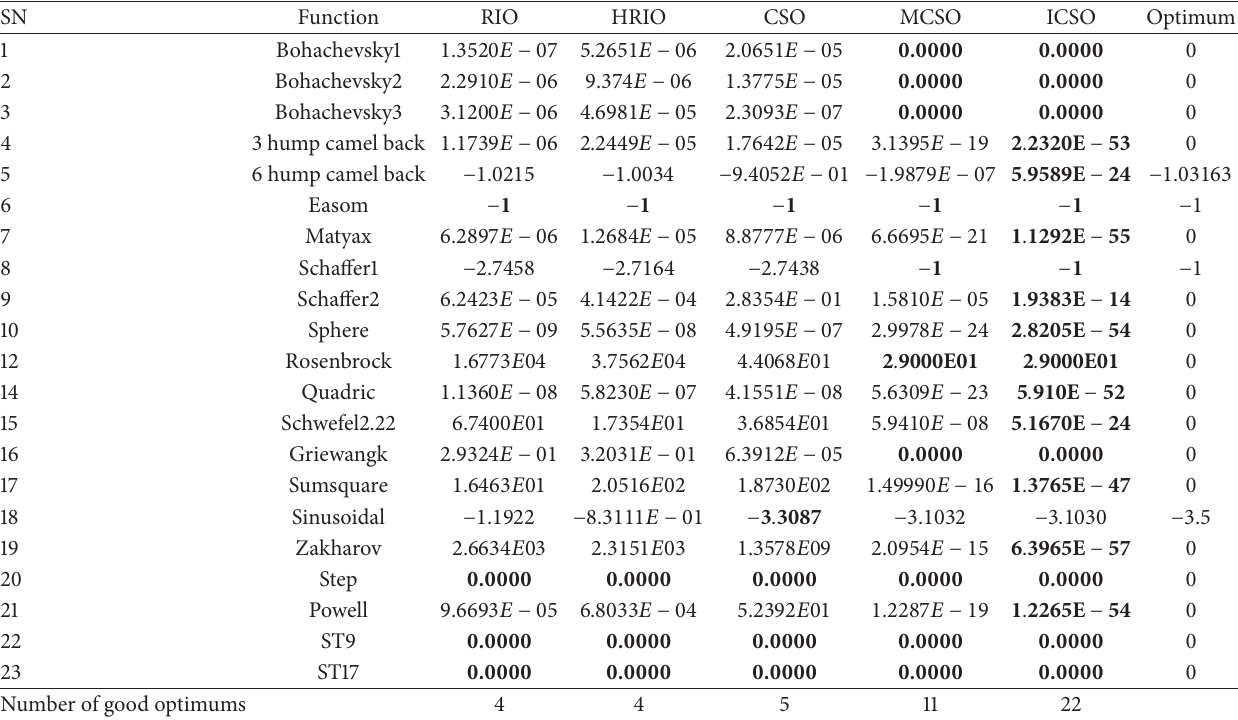
Table 6: Comparison of best performance of RIO, HRIO, CSO, MCSO, and ICSO. SN